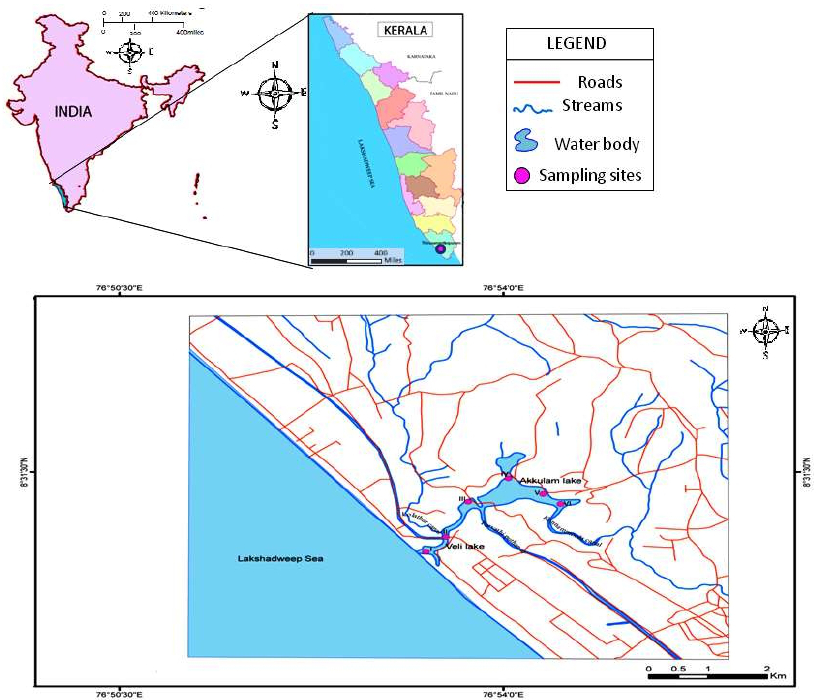
Fig. 1: Location map of Veli-Akkulam lake, India showing monitoring